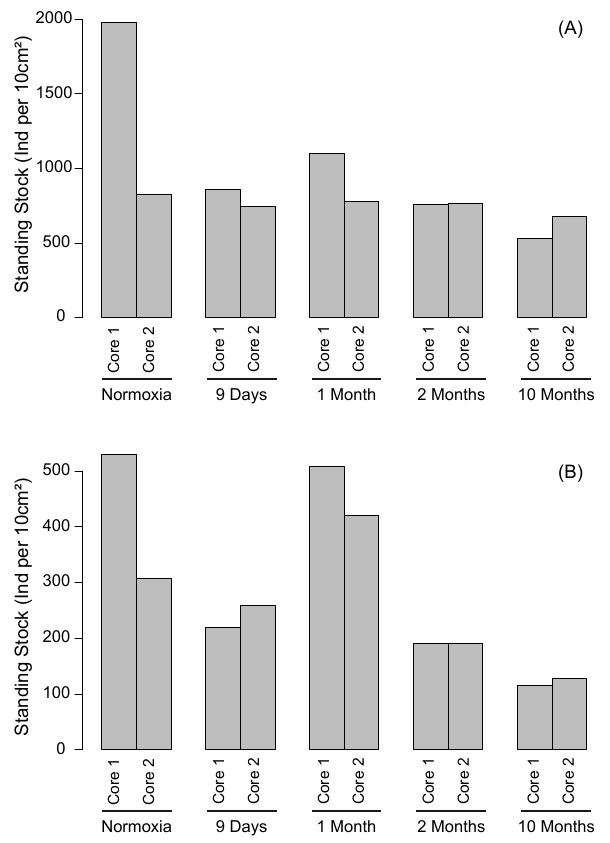
Fig. 1. Foraminiferal standing stocks in all sampled cores for the whole cores (0–5cm, panel A ) and for the 0–0.5cm depth intervals (panel B ).